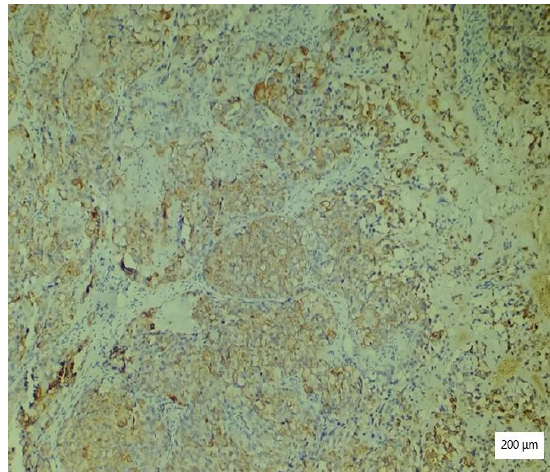
Figure 10. Negative vimentin in tumor cells (×100).